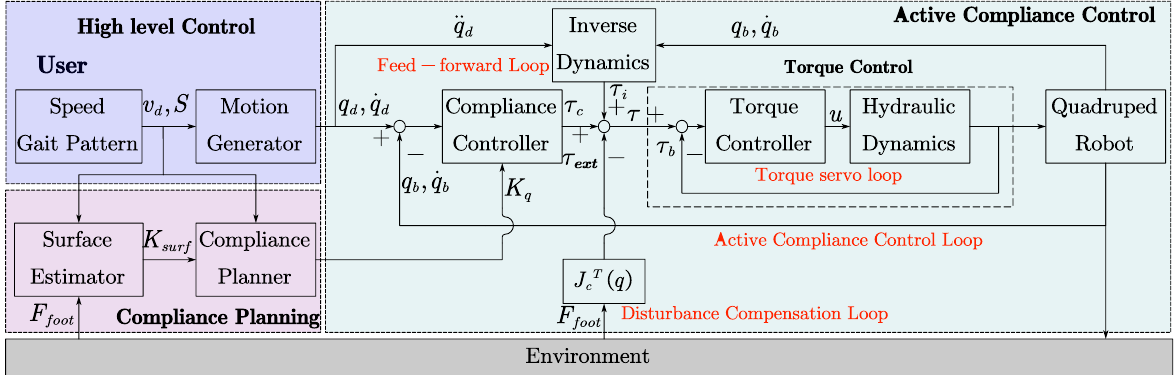
Figure 3. Block diagram of the bio-inspired compliance planning and control framework for the quadruped robot.